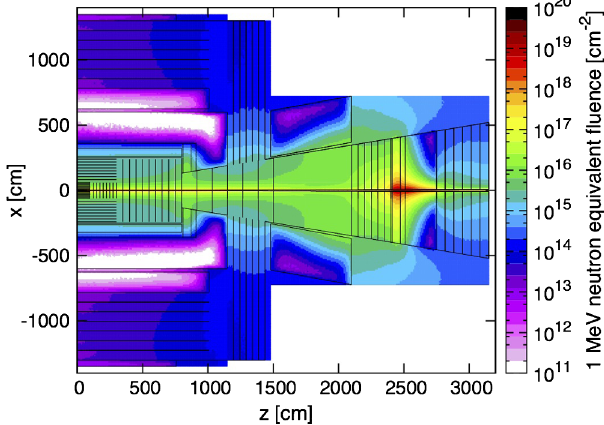
FIG. 9. 1 MeV neutron equivalent fluence for an integrated luminosity of 30 ab − 1 : top view. The same scoring resolution as the one of Fig. 5 has been adopted, apart from the central region ( R < 2 . 5 m and j z j < 8 m), where the considered radial reso- lution is 0.5 cm, instead of 1 cm.